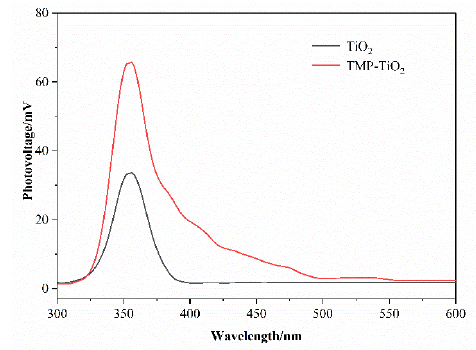
Figure 9. Surface photovoltage spectrum (SPS) spectra of TiO 2 and TMP ‐ TiO 2.